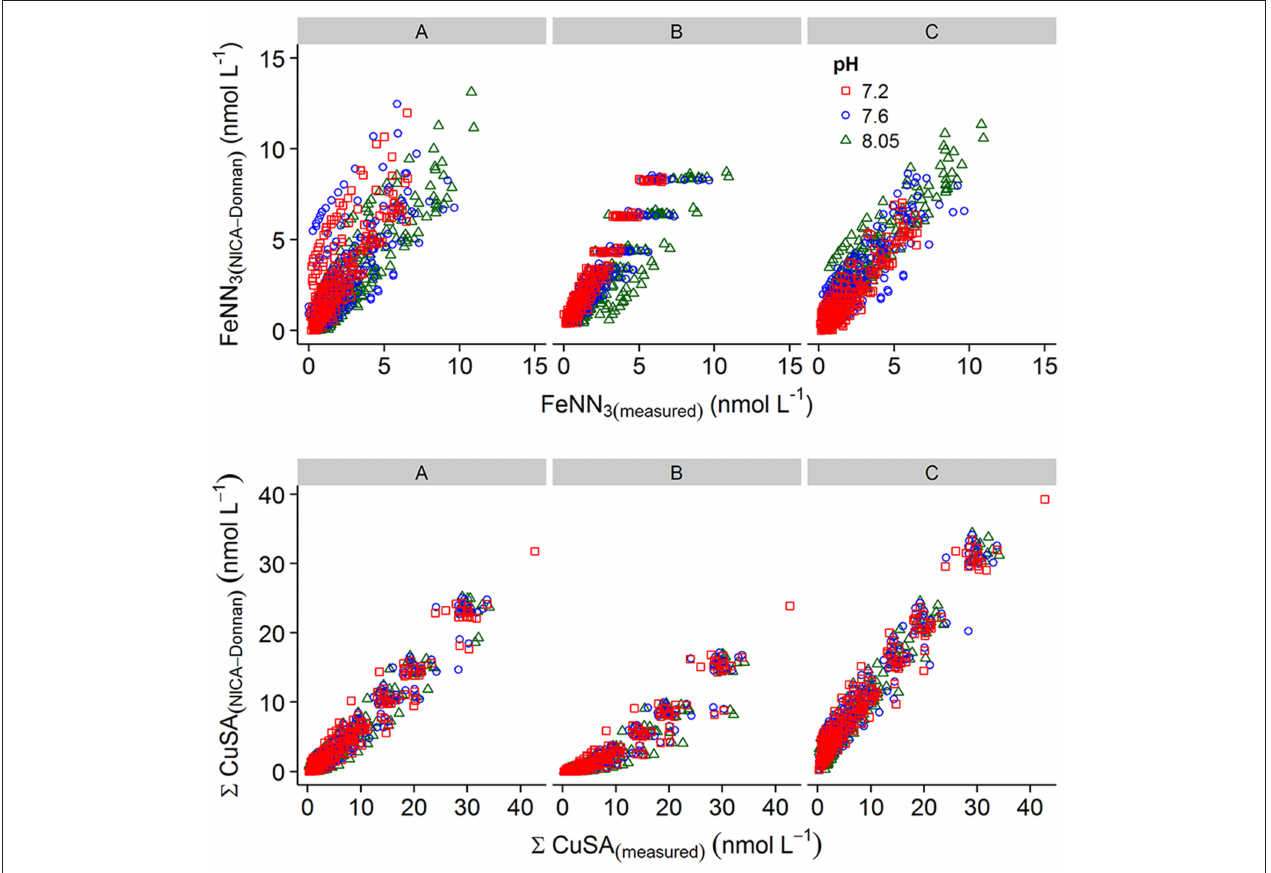
FIGURE 6 | Plots of measured versus calculated metal added ligand concentrations obtained using parameter sets (A–C) applied to the NICA-Donnan model in vMINTEQ. Top panel, iron; bottom panel, Cu. The applied parameter set is given above the graph. For details of the parameter sets, see Table 3 .